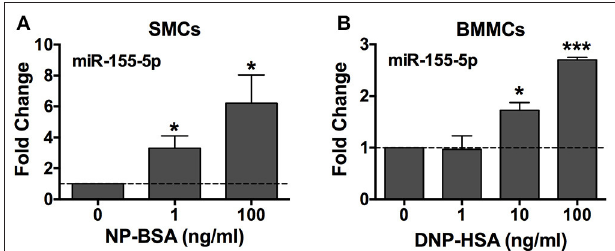
FIGURE 2 | Fc ε RI crosslinking induces miR-155-5p expression in human and mouse mast cells. Human SMCs isolated from tissues of different donors ( A , n = 3) and mouse BMMCs from male C57BL6 mice ( B , n = 3) were sensitized with anti-NP IgE or anti-DNP IgE, respectively, and activated for 3h at 37 ◦ C with 1–100ng/ml of the multivalent antigen NP-BSA or DNP-HSA. Changes in miR-155-5p expression were determined by quantitative RT-PCR using the 2 11 Cq method with SNORD96A as the internal reference control. The bar graphs represent mean ± SEM of values obtained from independent experiments with three different BMMC or SMC cultures from different mice or human donors. Significance was determined with Student’s t -test. * p < 0.05; *** p <